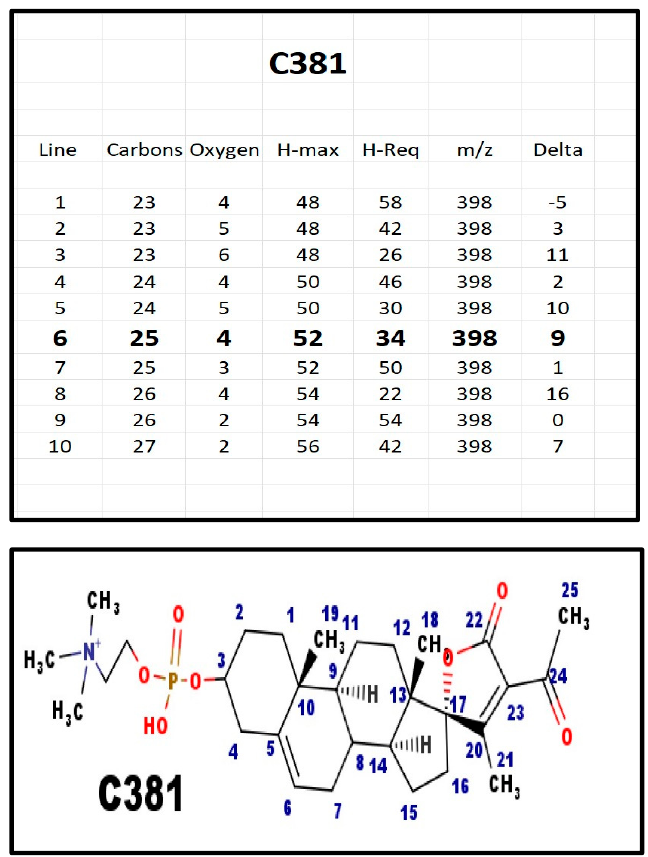
Figure A9. The proposed structures of C381.